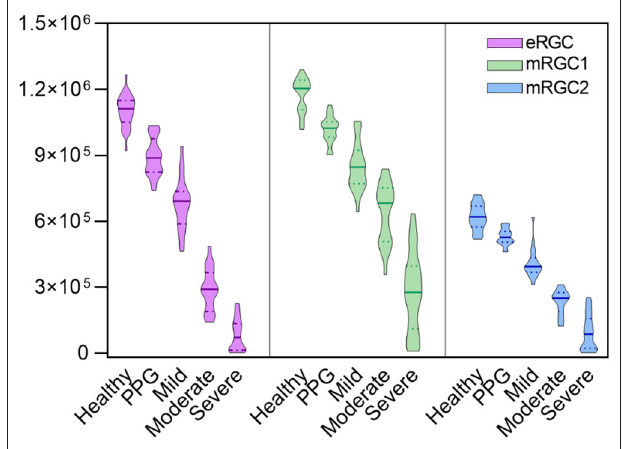
Frontiers in Medicine |